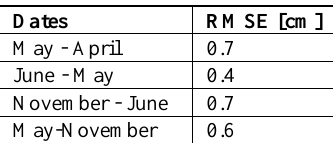
Georeferencing of the first model was made using the ten targets surveyed with DGNSS as illustrated on Figure 7. The computation was made using CloudCompare (Girardeau- Montaut, 2011) and the RMSE was found to be 1.8 cm.